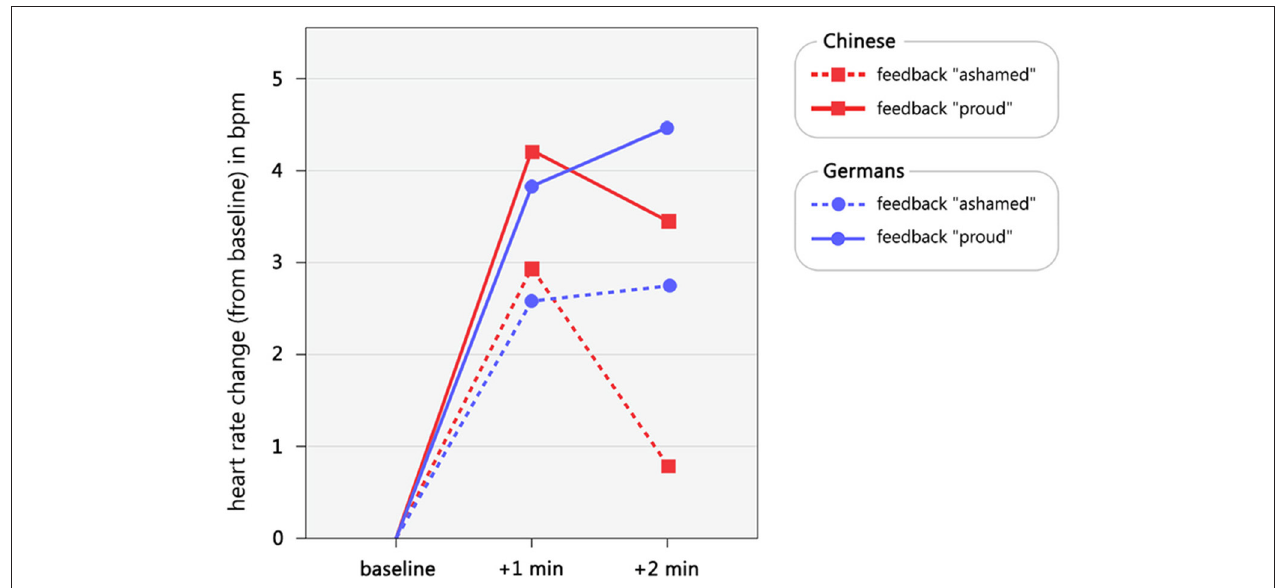
FIGURE 4 | The four experimental groups’ heart rate changes in bpm, compared to their respective baseline value.